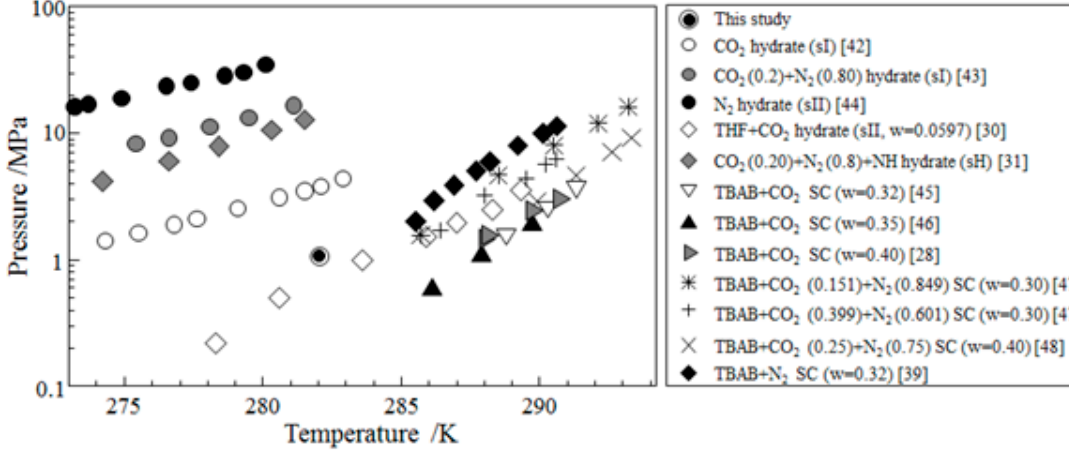
Figure 2. Formation conditions of gas-containing semi-clathrate hydrates and gas hydrates [28,30,31,39,42–48]. Double circle represents formation condition in the present study. Here, w denotes mass fraction of promoters in aqueous phase. NH: neohexane; TBAB: tetra- n -butylammonium bromide; THF: tetrahydrofuran.